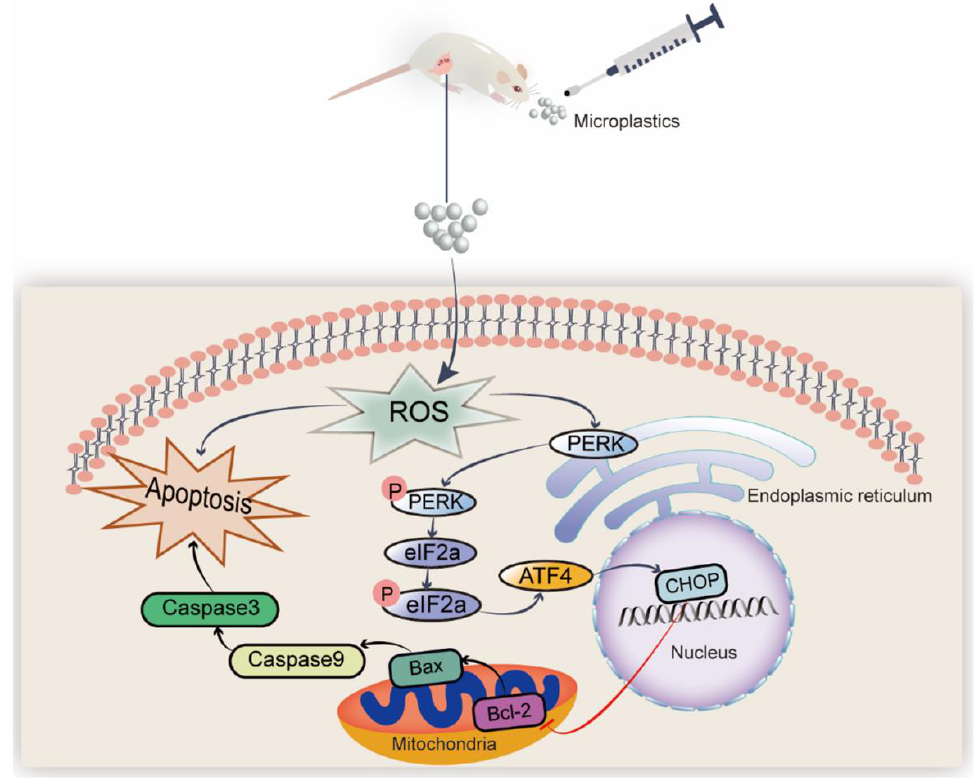
Figure 8. A proposed route of ovarian injury induced by PS-MPs administration. PS-MPs consumption enhanced the buildup in oxidative stress and then caused mitochondrial apoptosis by activating PERK-ATF4- eIF2α - CHOP molecular cascade. “ ↑ ” activation, “ ⊥ ” inactivation, and “P” phosphorylation.